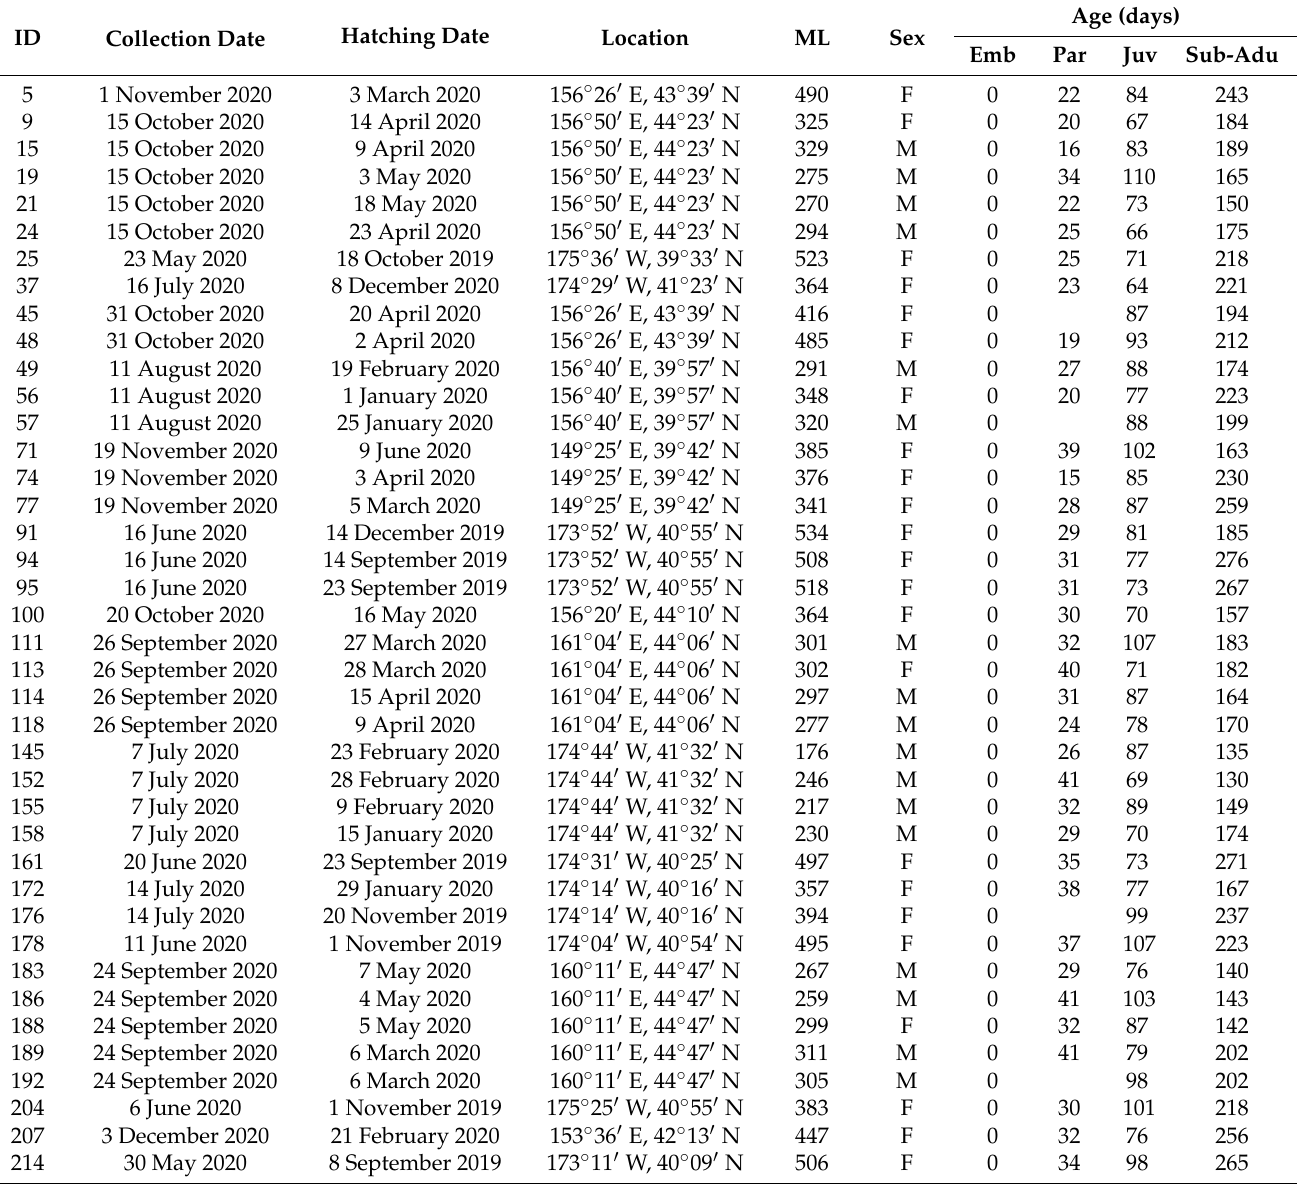
Table 2. Biological information for O. bartramii .